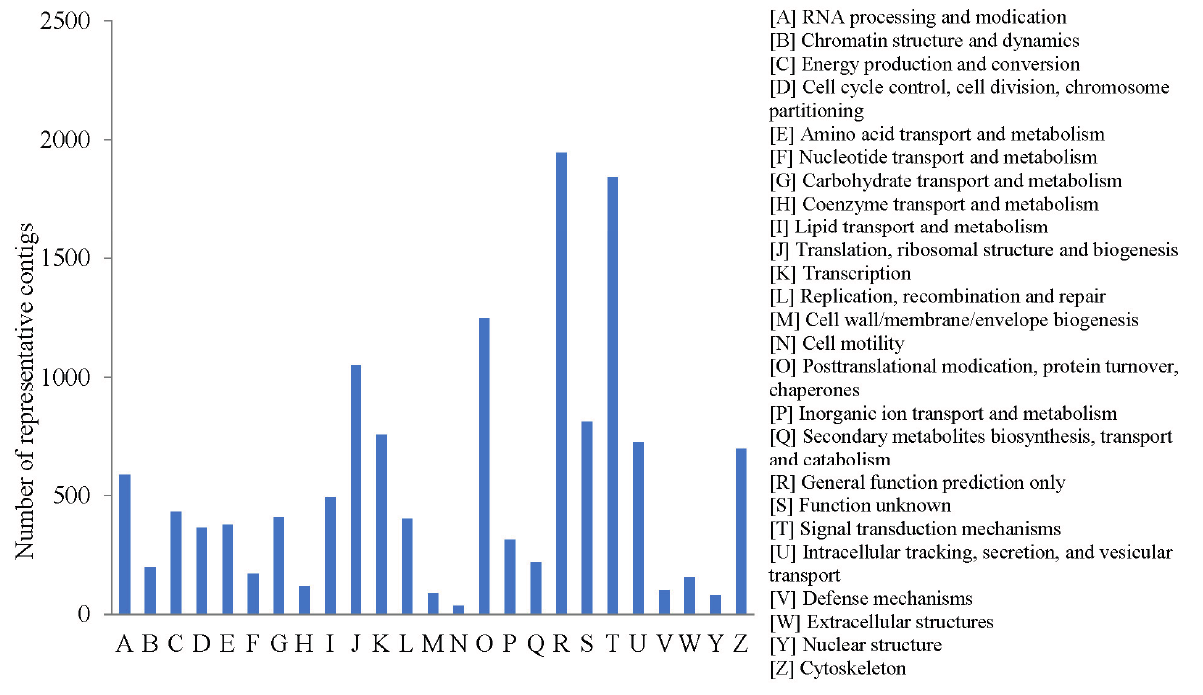
Figure 5. Clusters of Orthologous Groups (COG) classification of the sea cucumber coelomocytes transcriptome representative